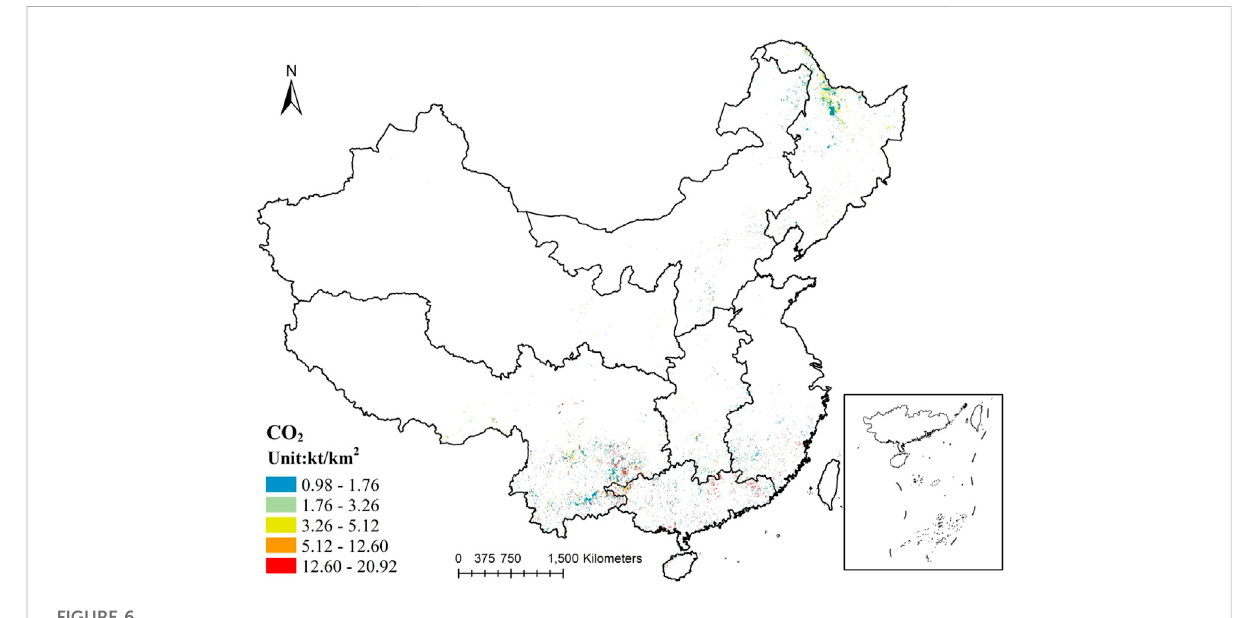
FIGURE 6 The spatial distribution of emissions of CO 2 in China in 2018.